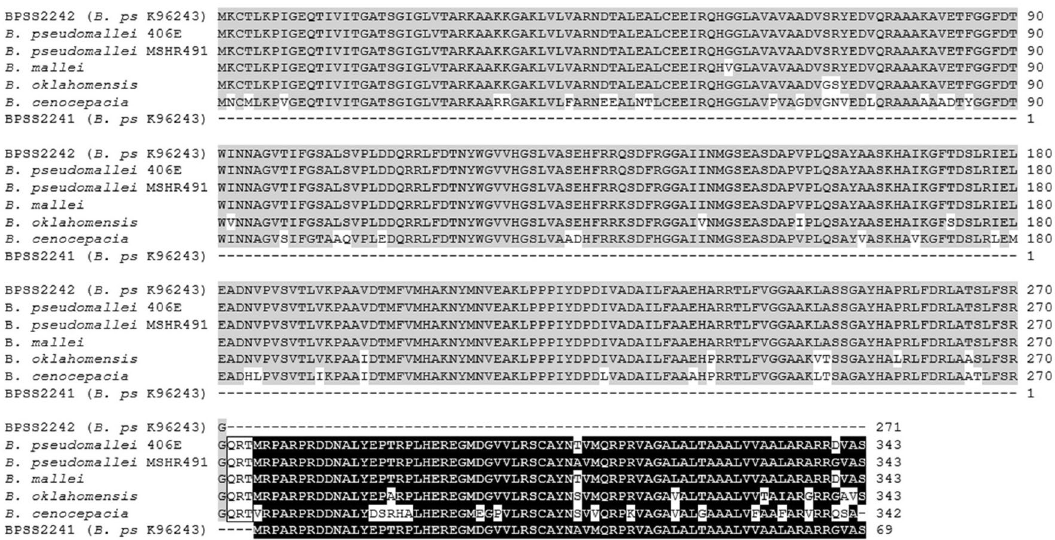
Figure 1. Multiple sequence alignments of BPSS2242 and BPSS2241 from B. pseudomallei K96243 and SDRs from other pathogenic Burkholderia . Homologs of BPSS2242 and BPSS2241 are shaded in gray and black, respectively. Box indicates additional amino acids found in other